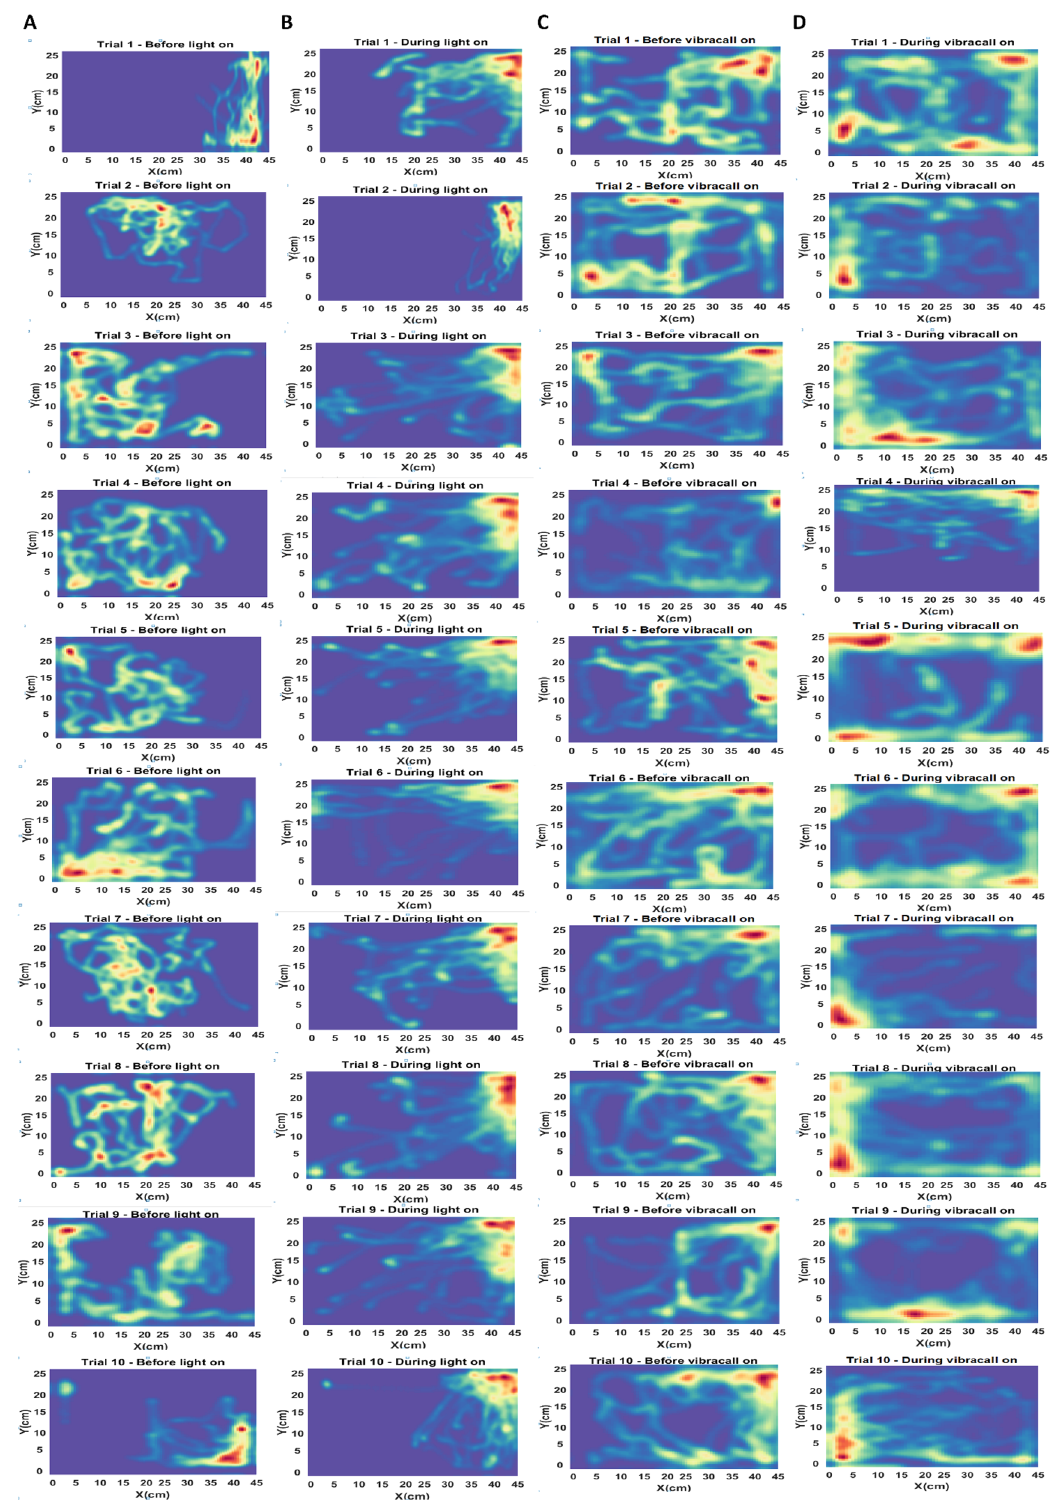
Figure 6. Thermal maps of the zebrafish’s location during complex conditioning (red and vibracall). The heat map contains records of the zebrafish’s location during training. At the moment when the stimulus was triggered, most fish moved to the delimited area of each stimulus, being the right side for the red LED light stimulus and the left side for the vibracall stimulus. ( A ) location of the fish before the red LED light was on, ( B ) location of the fish while the red LED light was on, ( C ) location of the fish before the vibracall stimulus on and D) location of the fish during the vibracall stimulus